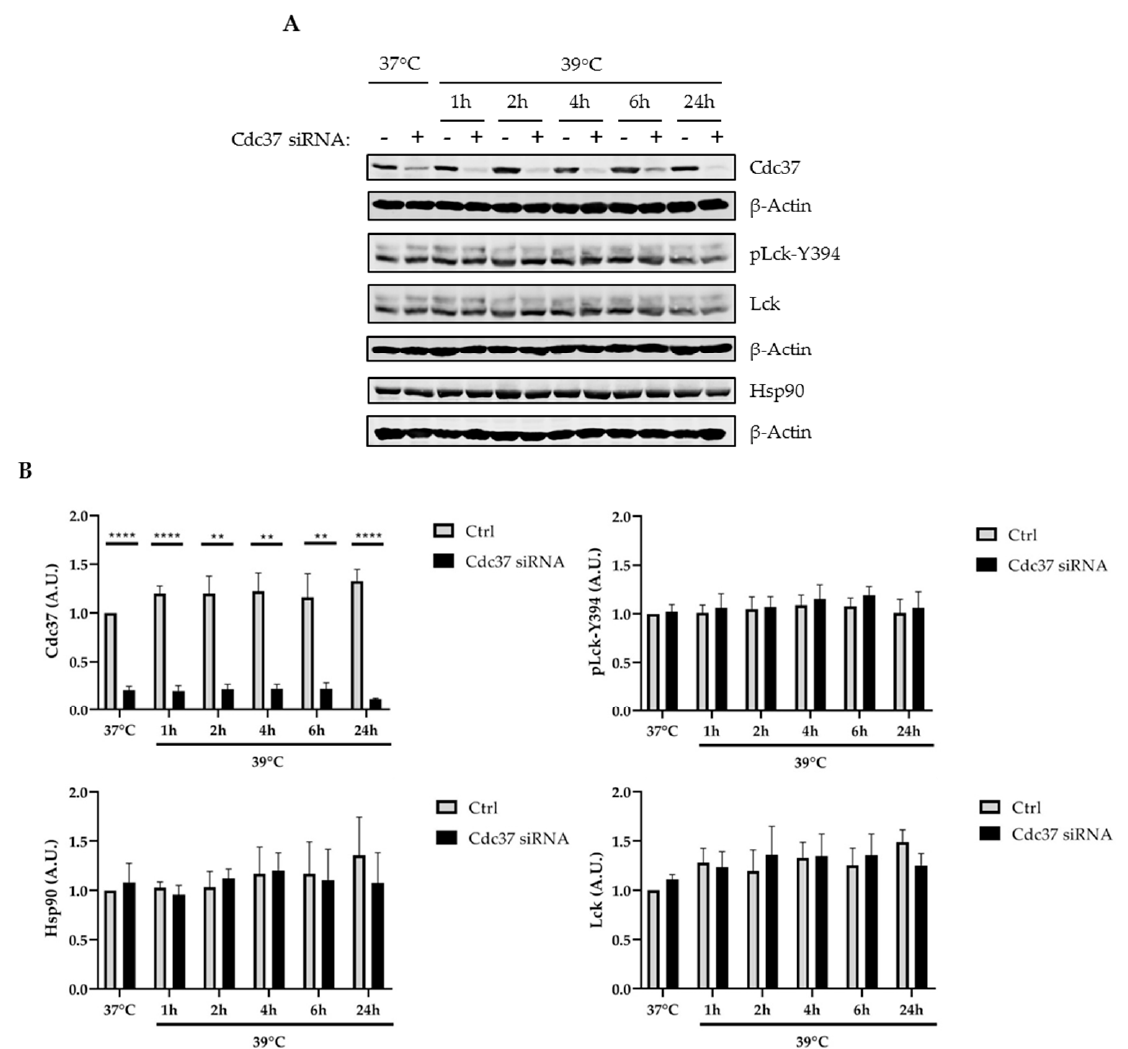
Figure 3. Cdc37 suppression did not influence Lck phosphorylation and expression under stress condition. JE6 cells were transfected with Ctrl ( − ) or Cdc37 (+) siRNA and cultured for 48 h. After 48 h, cells were incubated at 39 ◦ C for indicated time points. Subsequently, cell lysates were analyzed by immunoblotting using the indicated antibodies. ( A ) Immunoblots showing the expression of the indicated molecules. Bands in ( A ) were quantified using the ImageStudio software and values of Lck-pY394 were normalized to the total Lck signal, whereas signals of the total proteins were normalized to the corresponding β -actin signal. ( B ) Graphs show the expression levels of the indicated molecules as arbitrary units ± SEM of four independent experiments. Significant p -values were calculated using the Student’s t -test (**, p < 0.01; ****, p <